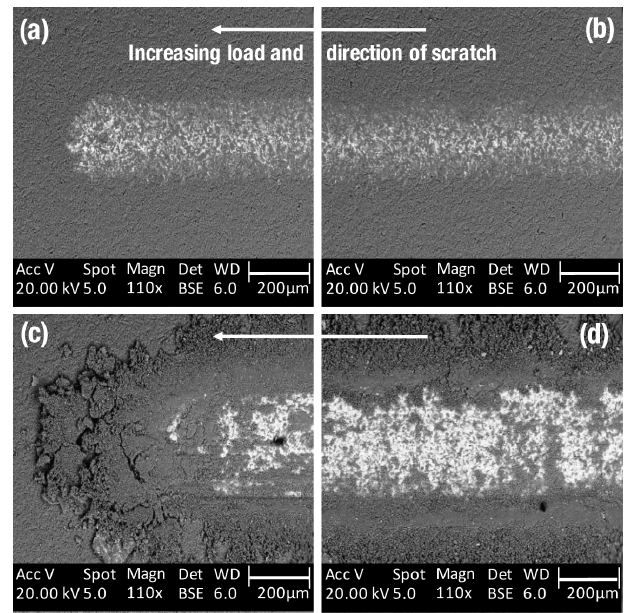
Figure 6. SEM images of a wear scar on a sample with 9% and 35% TiB 2 (images ( a , b ) showing the finish and middle sections of the scratch) and a sample with 35% TiB 2 (images ( c , d ) showing the finish and middle sections of the scratch). The arrow shows the direction of the scratch.